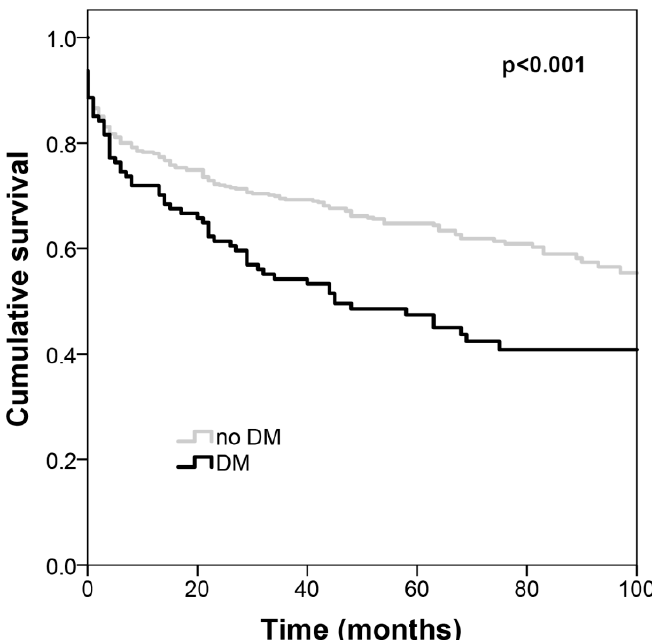
Figure 1. Kaplan–Meier survival curves of patients with acute PE according to the coexistence of DM. Diabetics have worse survival. PE: pulmonary embolism; DM: diabetes mellitus.